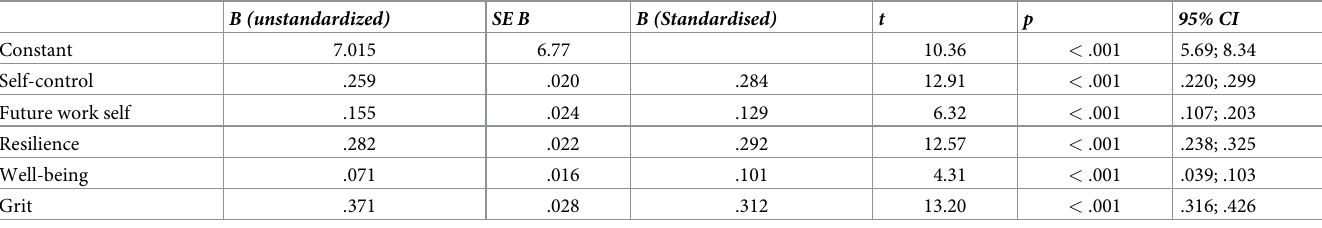
Table 5. Results from a multiple linear regression for predicting tenacity (BUSS). B